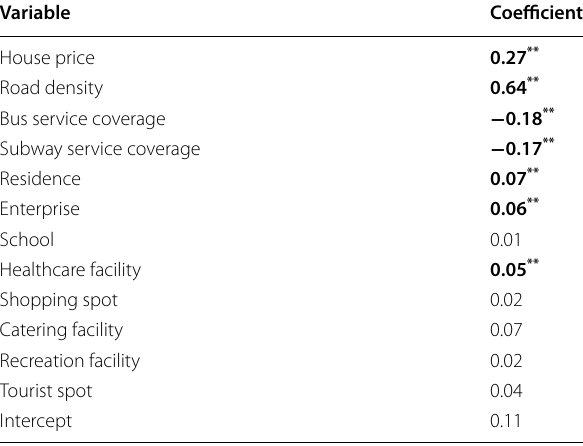
Table 2 Results of Multiple Linear Regression on the origin side